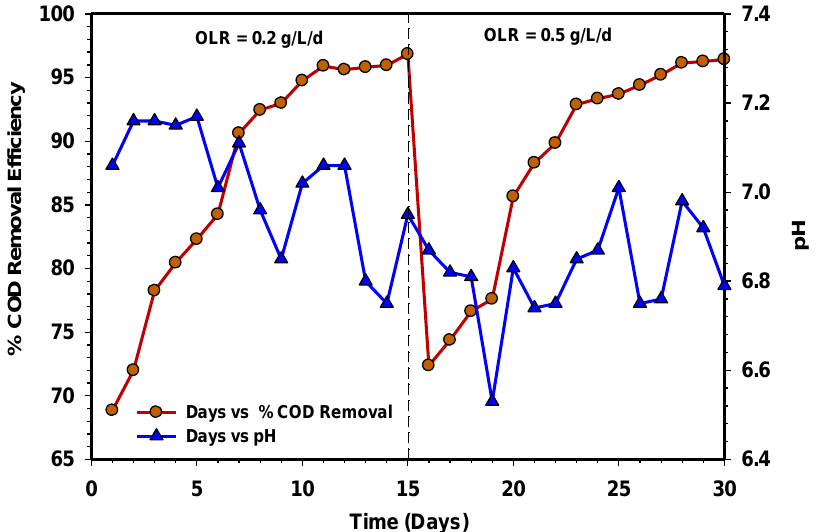
Figure 3. Acclimation period UASB 2 showing COD removal efficiency and pH profile.